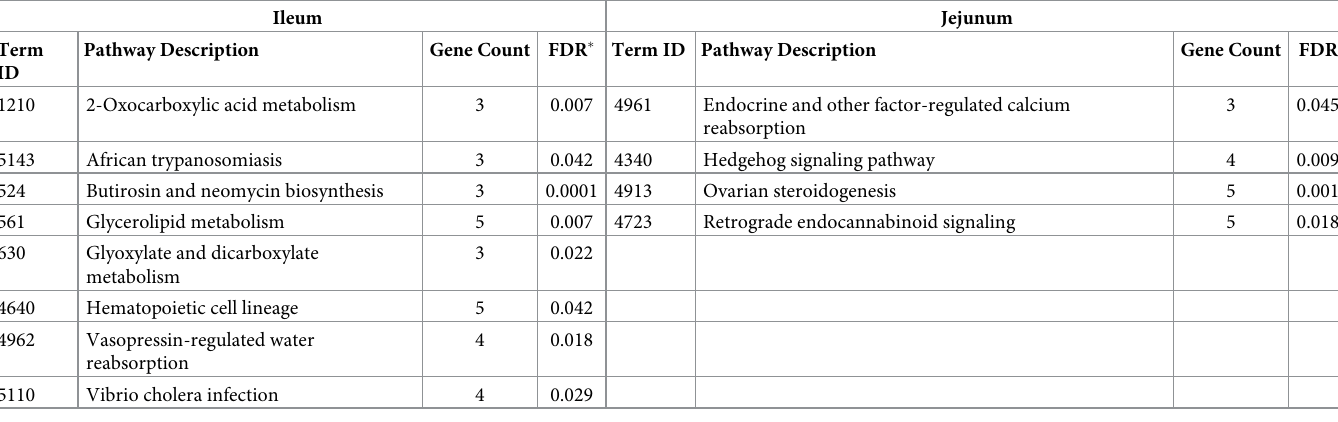
Table 5. Unique KEGG pathways observed in the ileum or jejunum, but not both tissues, from supplement-fed chickens compared to those on the control diet. Ileum Jejunum Term Pathway ID